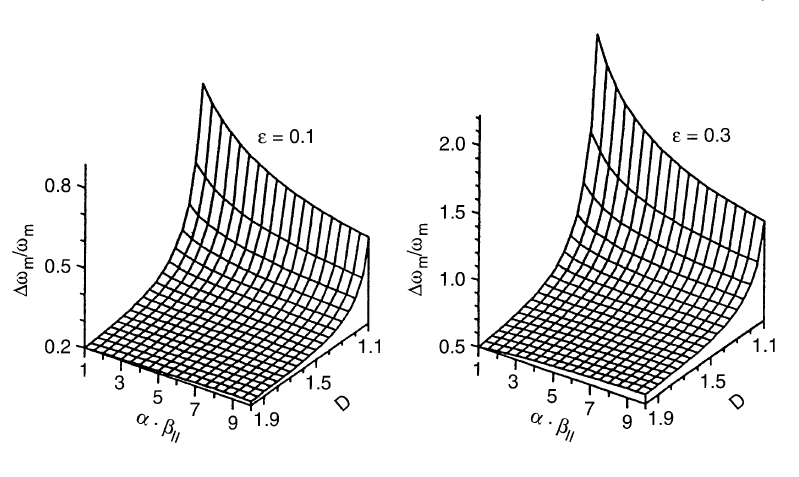
Fig. 4. Relative frequency shift of maximum in the equatorial growth rate as a function of (cid:97)(cid:98) (cid:69) and D for moderate ( (cid:101) " 0.1) and strong ( (cid:101) " 0.3) perturbation of the magnetic field, B (cid:122) , in the magnetosphere equatorial plane, (cid:101) " (cid:68) B (cid:122) / B (cid:122)